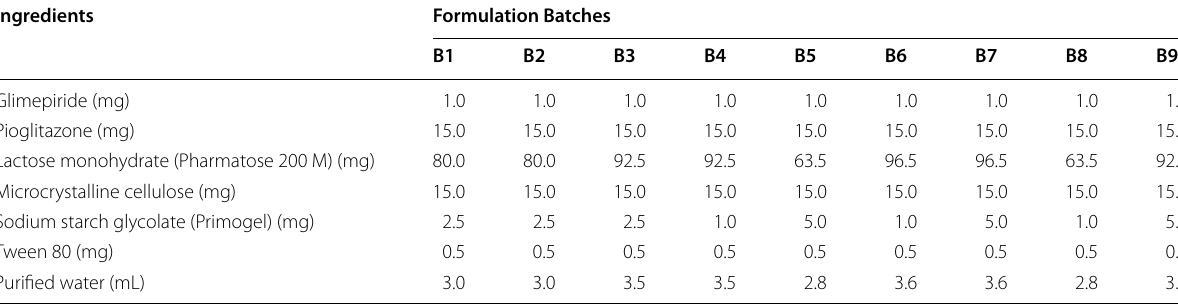
Table 3 Composition of different formulations of Glimepiride and Pioglitazone pellets